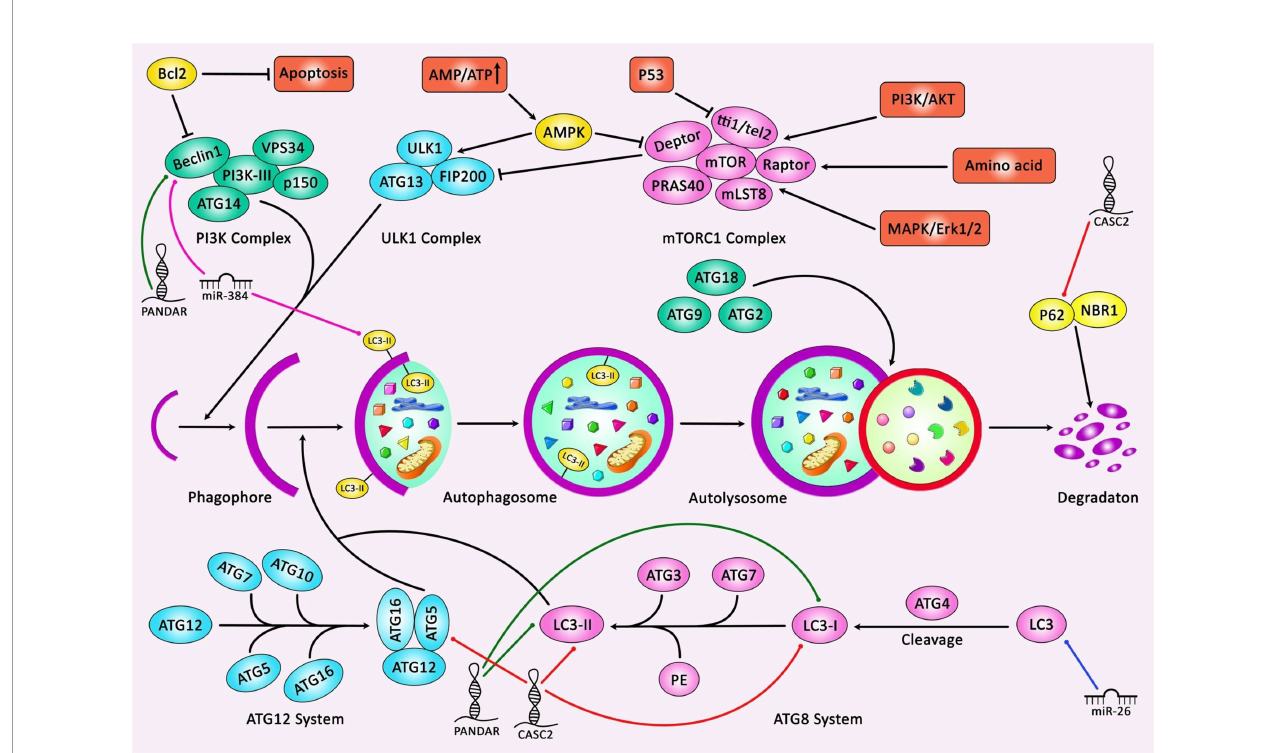
FIGURE 2 | A schematic summary of the role of various non-coding RNAs in modulating the process of autophagy in human lung cancer. Several non-coding RNAs affect lung cancer progression through modulating autophagy and apoptosis cascades in human lung cancer cells. As an illustration, overexpression of lncRNA PANDAR as a tumor suppressor via directly targeting Beclin-1, LC3-I and LC3-II could activate both autophagy and apoptosis cascades, and thereby suppressing progression of lung cancer (14). In addition, lncRNA CASC2 could suppress autophagy and enhance apoptosis pathway in non-small cell lung cancer cells through modulating the miR-214/TRIM16 axis. Moreover, p62 expression level was signi fi cantly elevated but Atg-5 expression and the ratio of LC3-II/LC3-I were considerably reduced in the CASC2-overexpressing cells